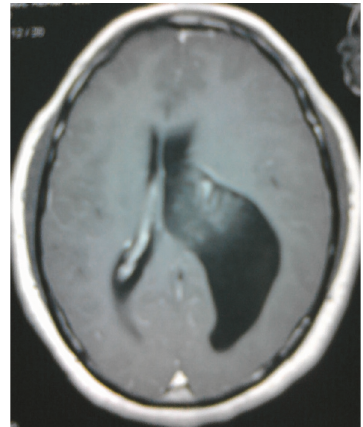
Figure 4: T1 image axial view postcontrast